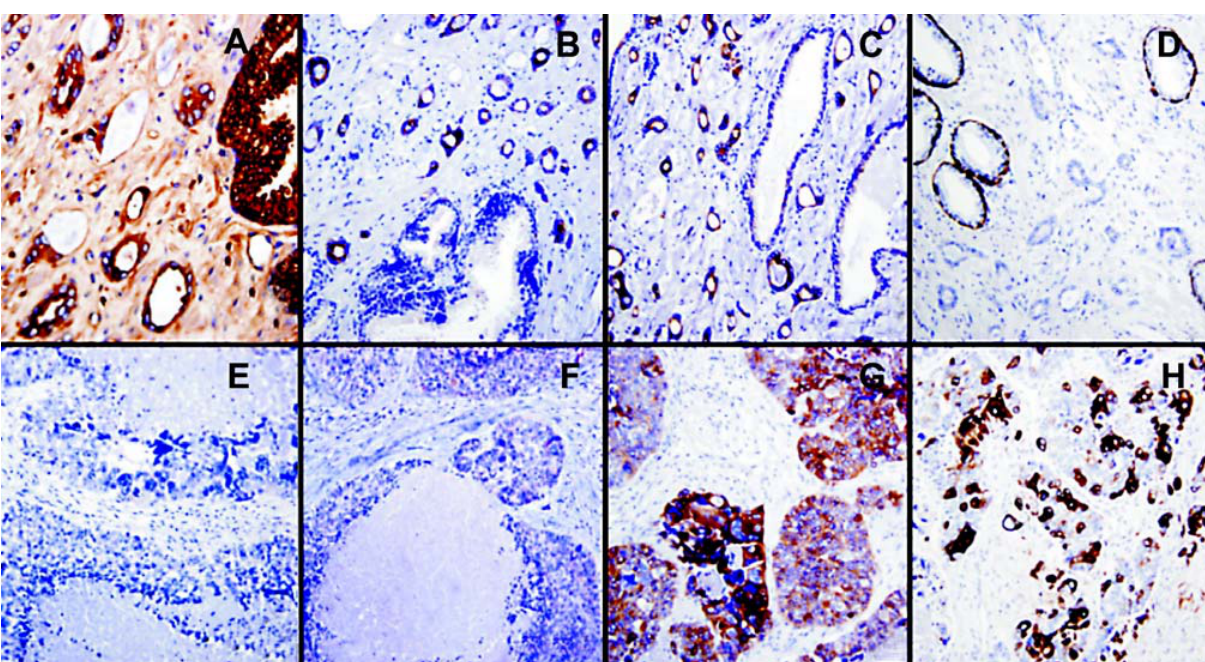
Figure 4 – Immunohistochemical results in conventional prostatic acinar adenocarcinoma (A-D) and urothelial-type adenocarcinoma in prostatectomy specimen. The conventional acinar adenocarcinoma was positive for PSA (A), AMACR (B), and CK7 (C), but negative for HMWCK (D). The urothelial-type adenocarcinoma was negative for PSA (E) and AMACR (F) but positive for CK7 (G) and HMWCK (H), Immunolabelling,